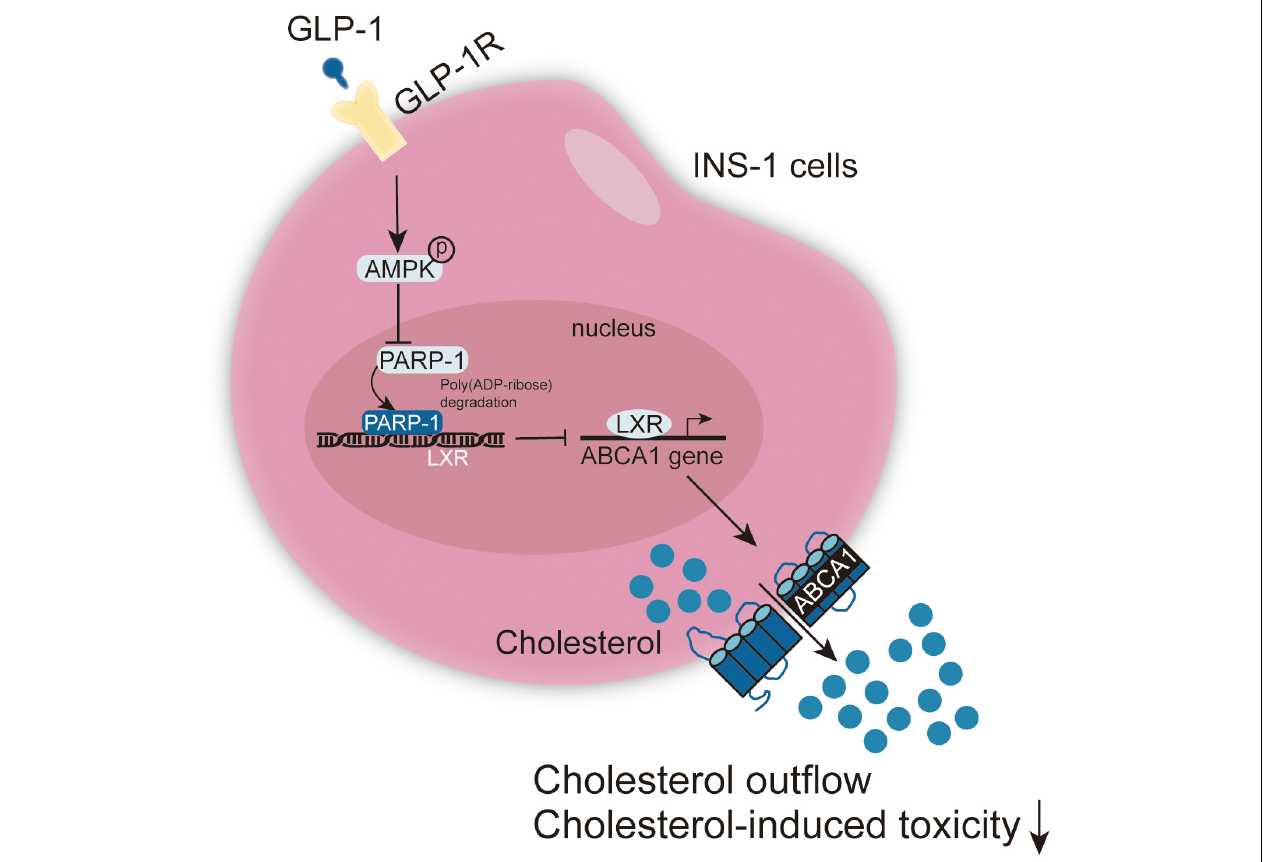
FIGURE 8 | A schematic graph of the mechanism. GLP-1 induces AMPK and LXR-mediated ABCA1 expression and inhibits PARP-1 to protect islet β cell function against cholesterol-induced toxicity in vitro and in vivo through enhancing cholesterol